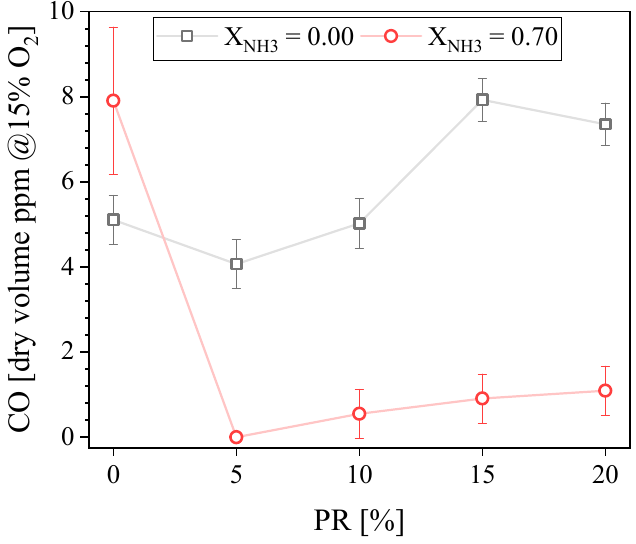
Figure 5. Measured CO concentration in the exhaust gases as a function of the PR.